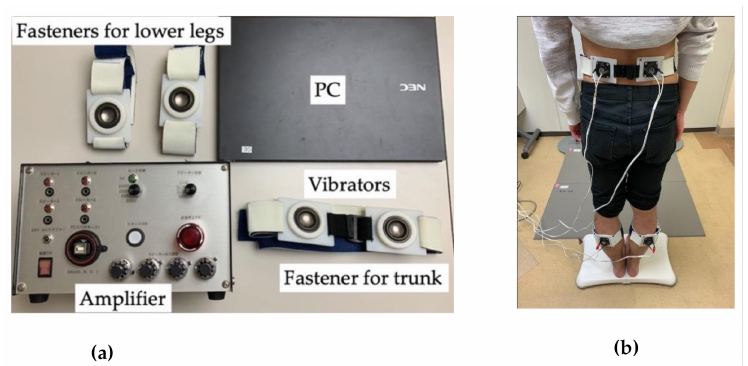
Figure 1. Diagnosis system for proprioceptive function: ( a ) Variable frequency local vibratory stimulation device; ( b ) Experimental setup for a